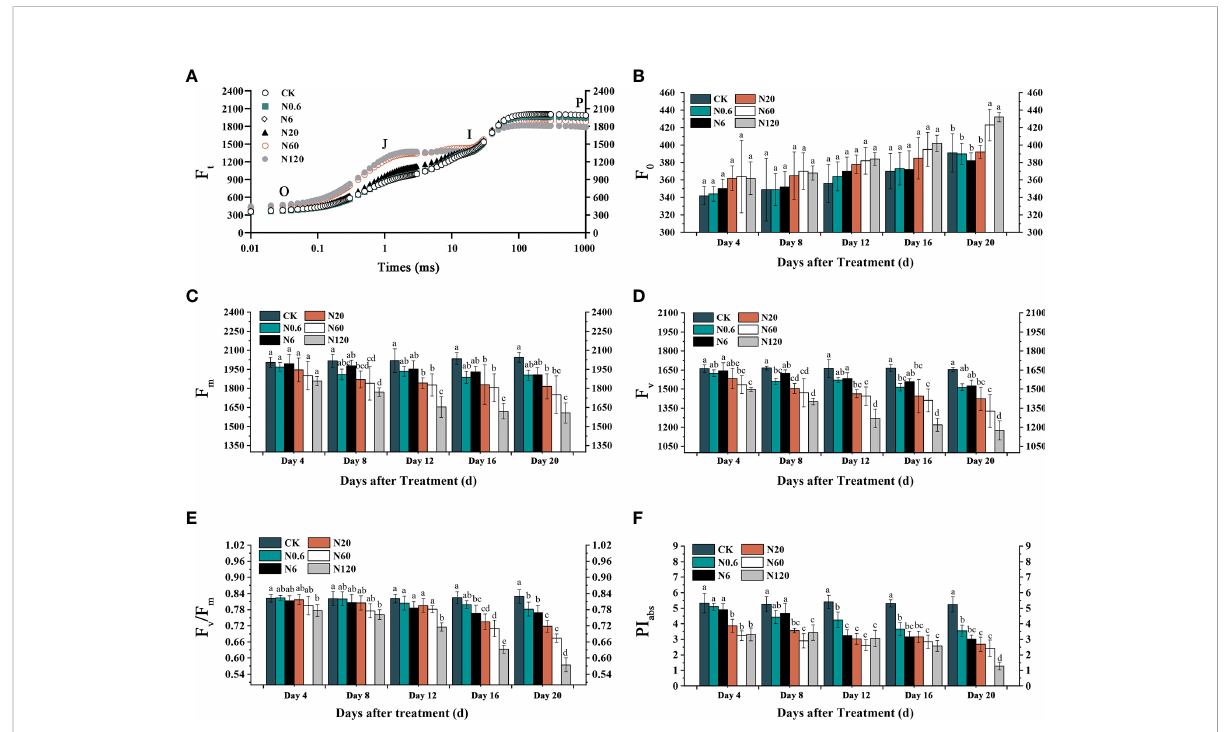
FIGURE 5 Effects of nicosulfuron on the PSII activity of sugar beet leaf. OJIP transient on 20 DAT (A) , F O (B) , F m (C) , F v (D) , F v /F m (E) and PI abs (F) in sugar beet with different doses of nicosulfuron. Data with the different letters indicate signi fi cant differences between different doses of nicosulfuron drift (n = 6, p <